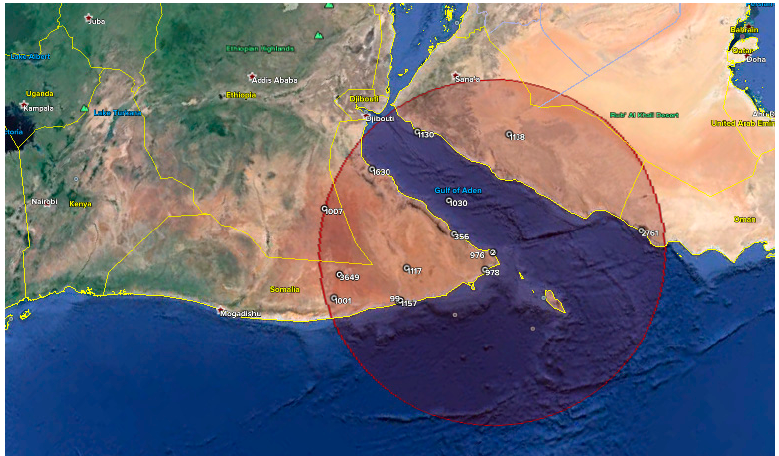
Figure 8. Results of spatial clustering of thematic cluster #2. An event cluster is generated surrounding Somalia and the Gulf of Aden. This cluster contains 17 location IDs, an observed/expected ratio of 3.41, a relative risk of 3.67, and a p -value of 0.00003.